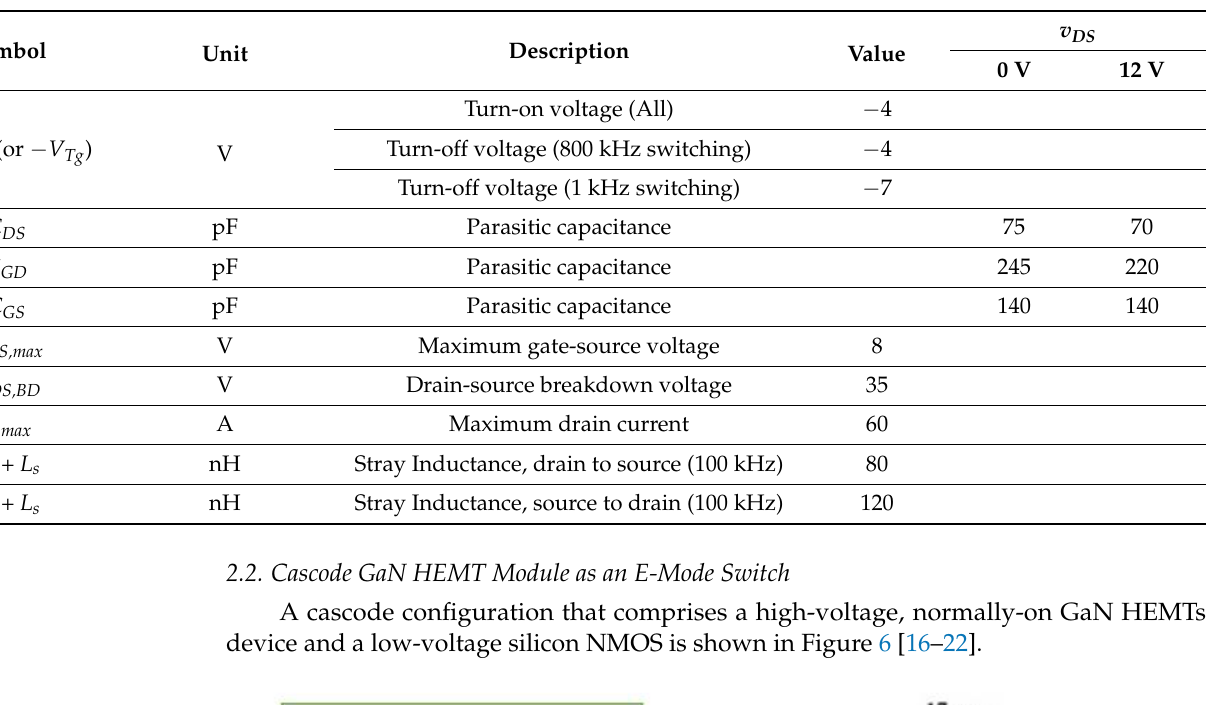
Table 1. Characteristics summary of the D-mode GaN HEMT.